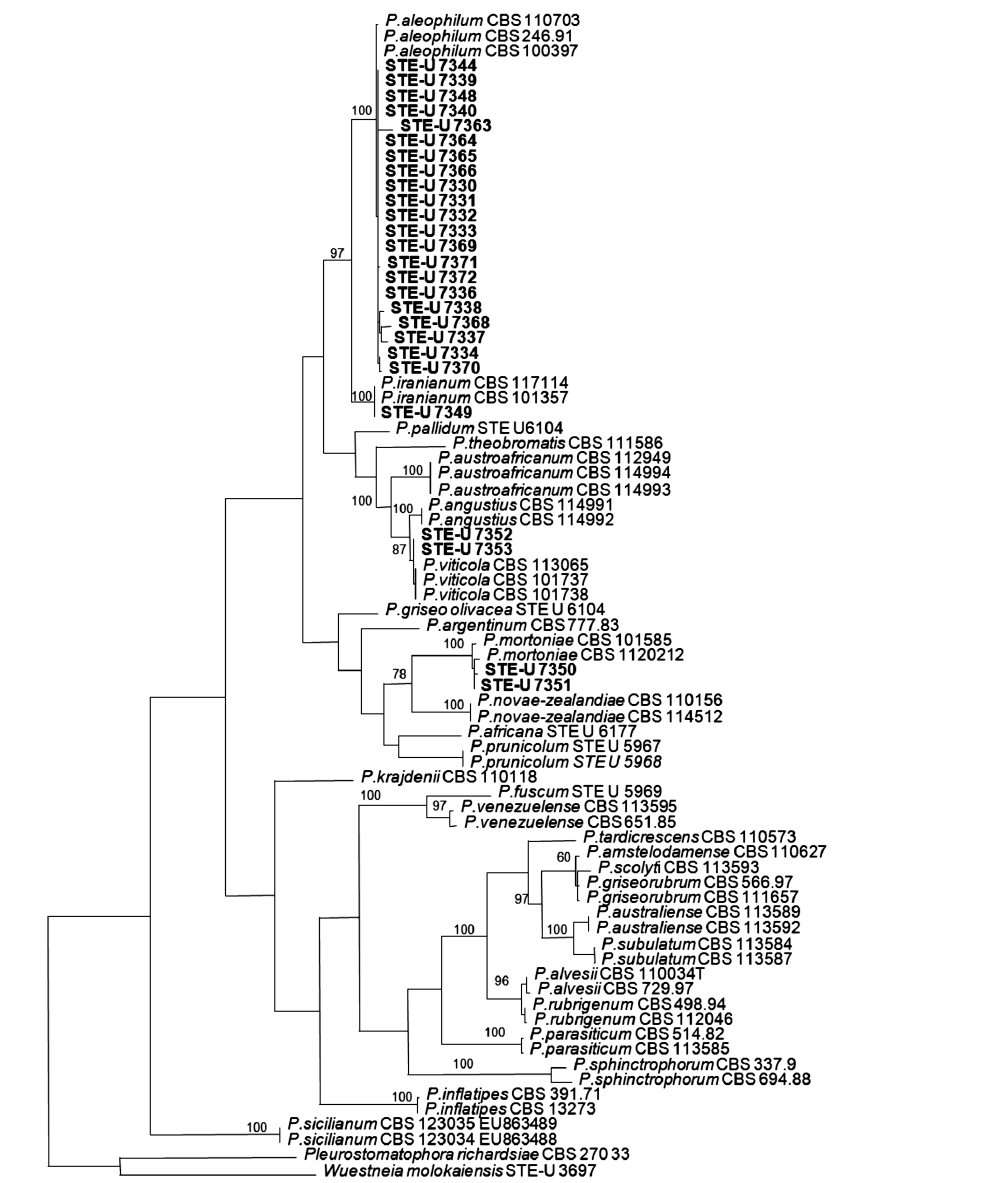
Figure 3. One of 190 most parsimonious trees obtained from b -tubulin region sequences of the Phaeoacremonium isolates . Bootstrap support values above 50% from 1000 replicates are shown at the nodes. Tree scores include TL = 1512, CI = 0.506, RI = 0.823, RC = 0.416, HI = 0.494. Isolates from the present study in